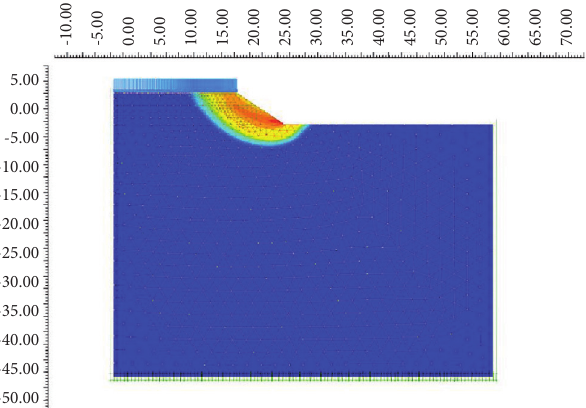
Figure 12: Displacement cloud map in the limit state.